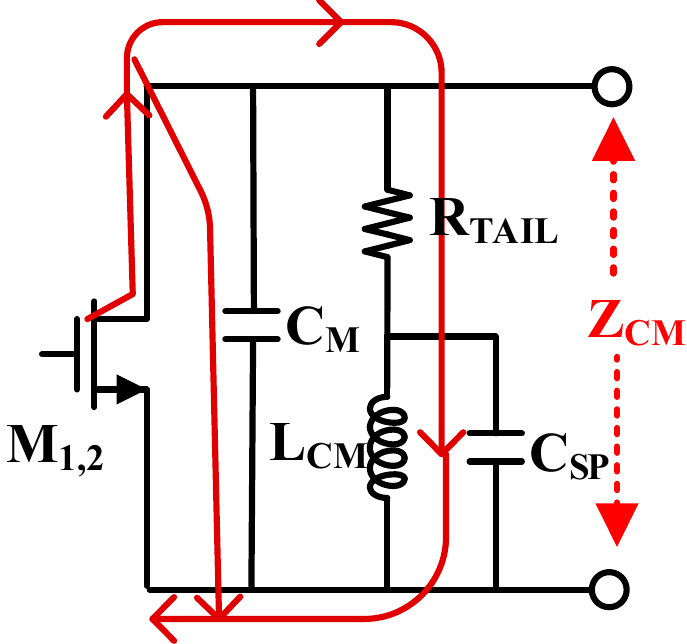
Figure 6. The implicit capacitive-bridged shunt peaking filtering network.